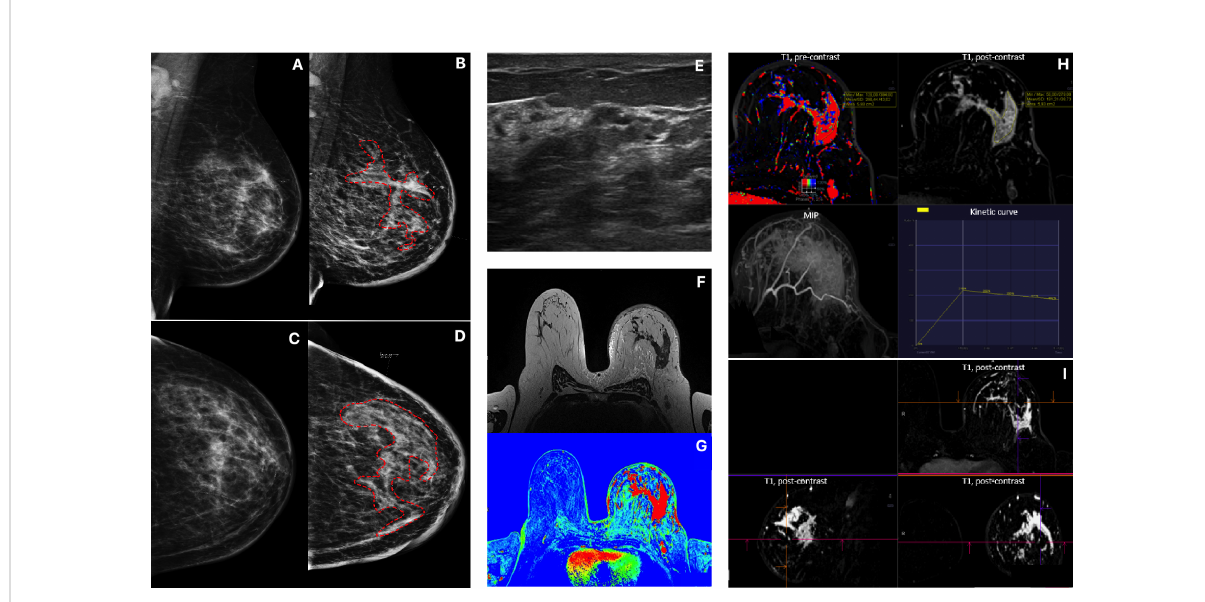
FIGURE 2 Patient 2, Multimodality presentation of Lobular Breast Cancer, left breast: (A, B) Mammography, [ (A) MLO and (B) CC] asymetric density cancer, cancer marked with red dotted line. (C, D) Mammography, [ (C) MLO and (D) CC] the same Patient after 4 months, cancer marked with red dotted line. (E) ultrasound- not circumscribed, hypoechoic region. (F) MRI T2 TSE - non-mass enhancement. (G) MRI T1 fl 3d dynamic PEI. (H, I) MRI - diffused, non-mass enhancement with heterogenous enhancement [ (H) T1 pre contrast; T1 post contrast; MIP and wash out kinetic curve; (I) 3D T1 post contrast].